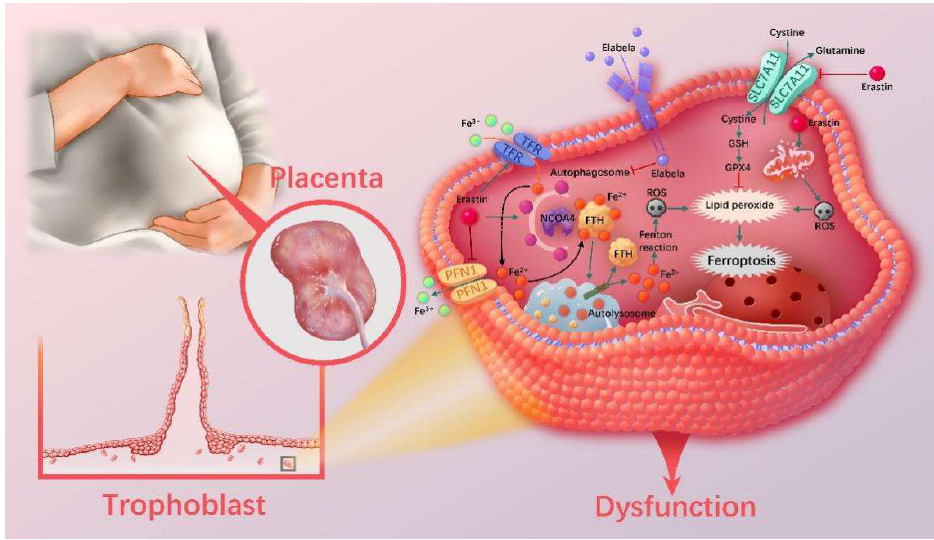
Figure 8. Schematic illustration of the mechanism of how Elabela and Erastin regulate ferroptosis in trophoblasts.